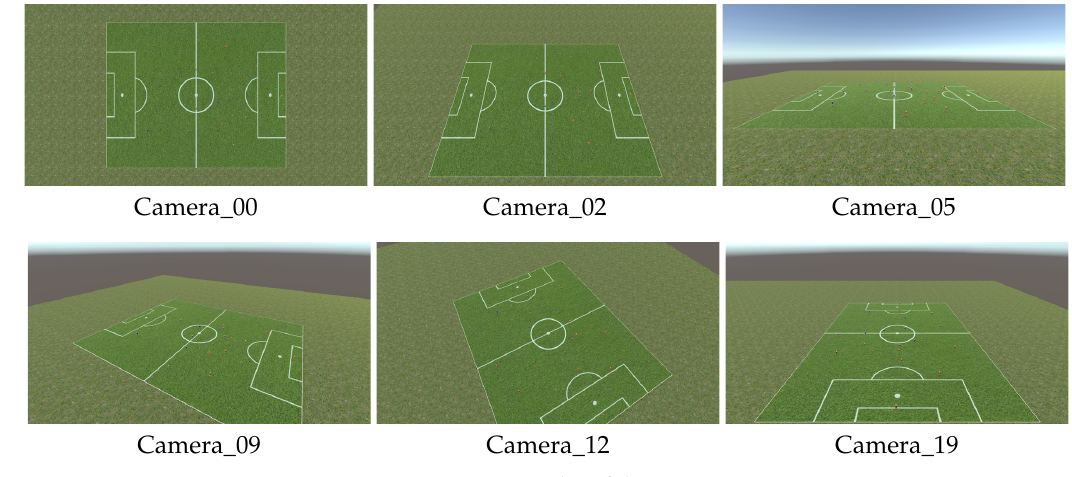
Figure 7. Examples of datasets.